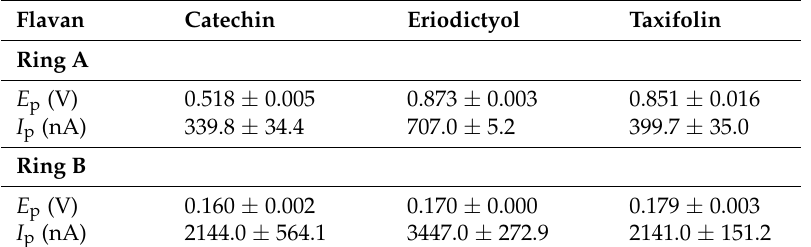
Table 1. Electrochemical variables for flavan ring A and ring B hydroxyl groups extracted from differential pulse voltammogram data (mean ± SD of three measurements)